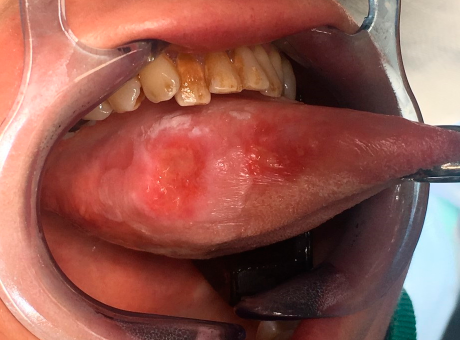
Figure 2. Preoperative image of Case 2 showing squamous cell carcinoma of the right mobile tongue.